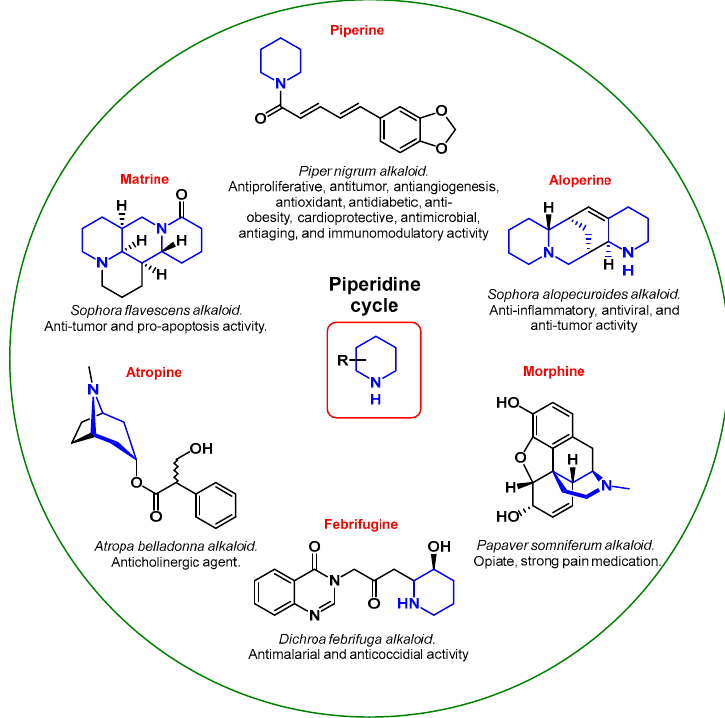
Figure 4. Pharmacological properties of natural piperidine derivatives.